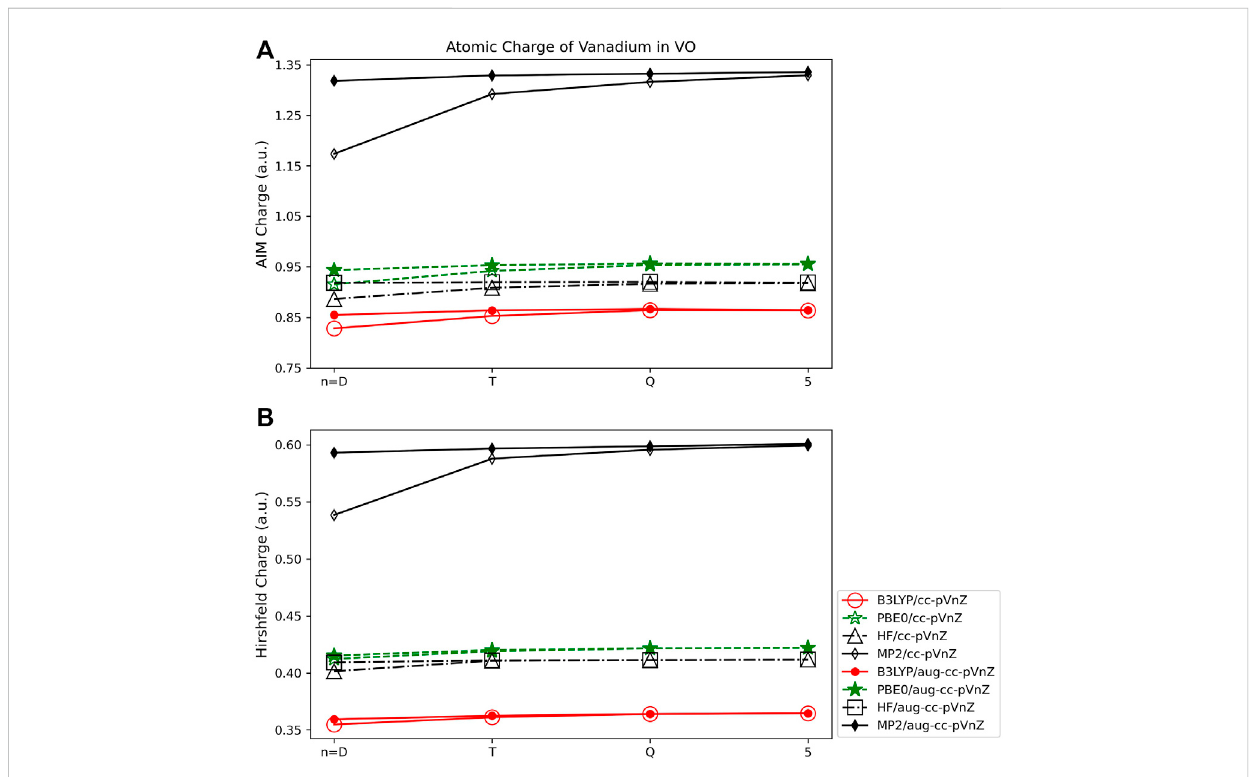
FIGURE 8 AtomicchargeofvanadiuminVOdeterminedusinganumberoftheoreticalmethods,Dunningstylebasissets,andpopulationanalysismethods: (A) AIM, and (B) Hirshfeld (*Note that scales vary from one analysis method to